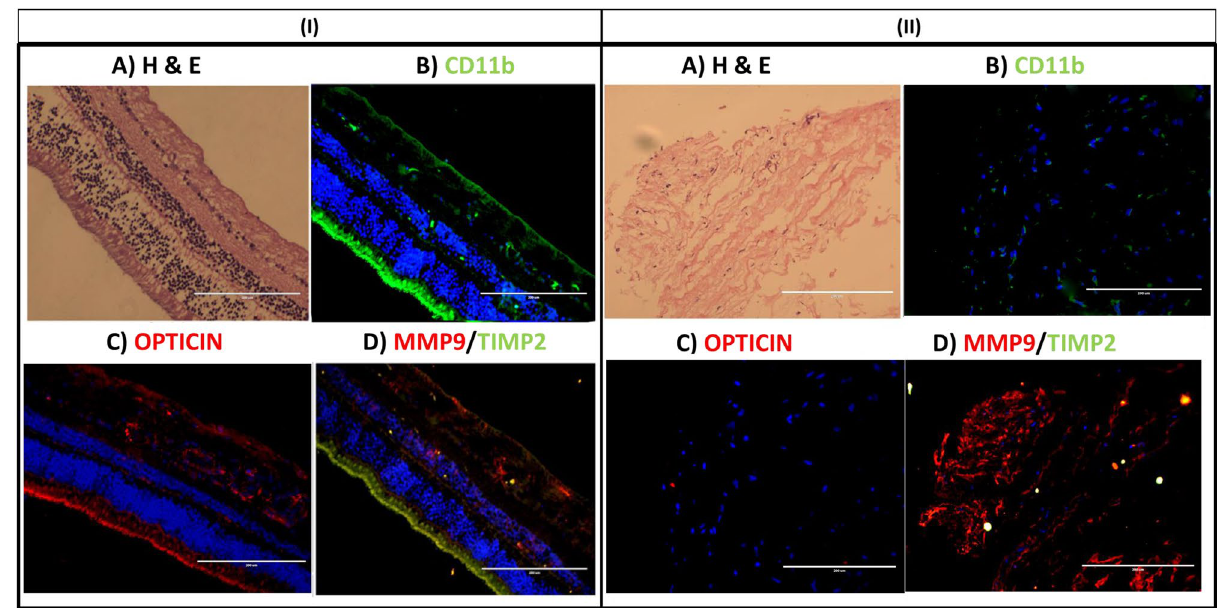
Figure 6. Representative image of H&E ( A ), immunofluorescence of CD11b ( B ), opticin ( C ), MMP9 and TIMP2 ( D ) in normal retinal tissue (I) and fibrovascular membrane (II, n = 3) collected from stage V ROP, (n = 3, 20× magnified, scale bar 200